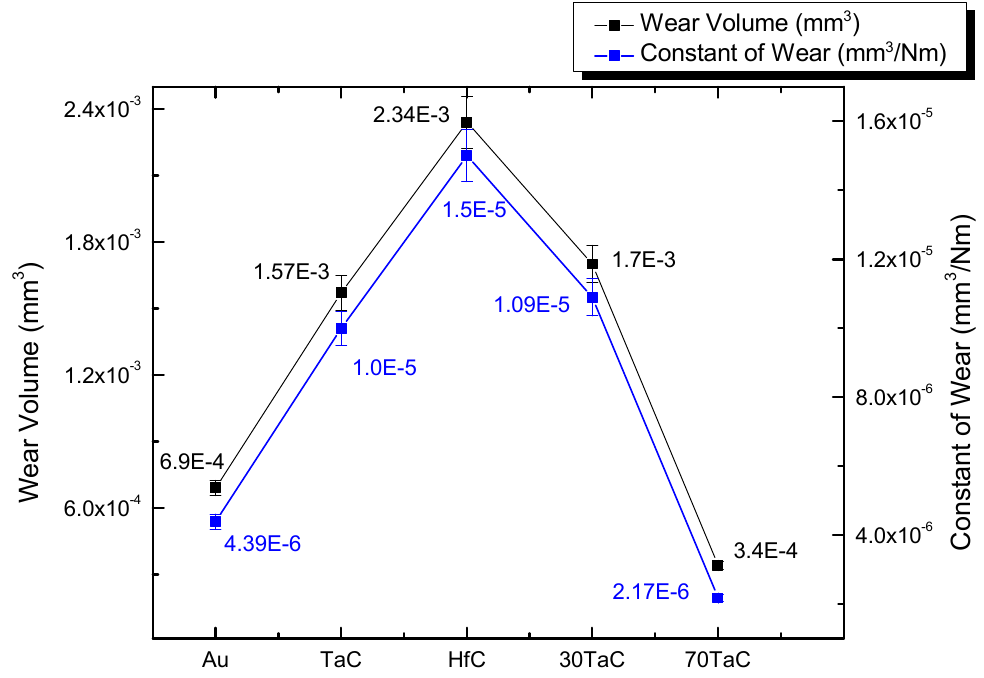
Figure 5. Contrast between the wear volume and constant of wear for each coated system.